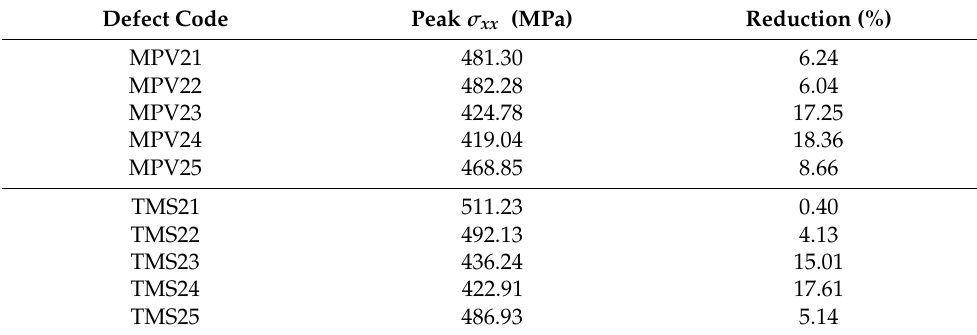
Figure 27. Effect of defects on nominal stress-strain curves for two-ply shifted plain weave unit cell: ( a ) MPV; and ( b ) TMS. Table 5. Peak nominal stresses and their percent reduction compared to no defect cases for two-ply shifted plain weave unit